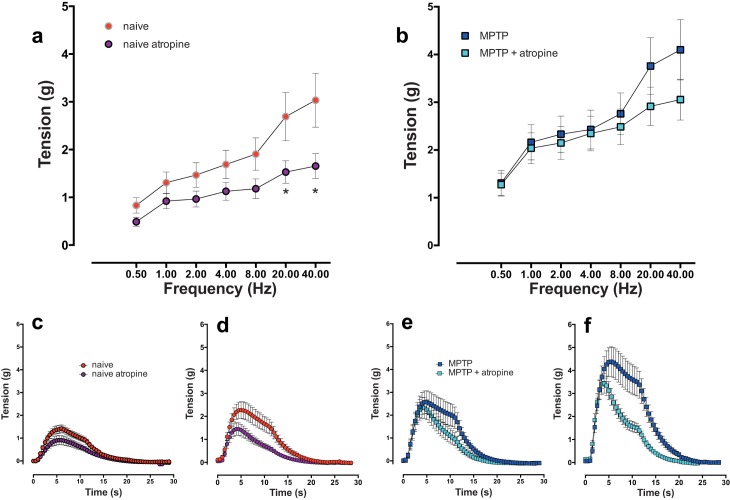
Frequency dependent increase in contractile response of isolated detrusor strips in response to trains of 20 pulses at frequencies ranging from 0.25 to 40 Hz in the absence or in the presence of 1 μM atropine in normal and equivalent tissues from MPTP animals respectively.In detrusor strips from drug naïve animals, atropine significantly inhibited peak contractile responses at frequencies above 20 Hz (a). In strips from MPTP-treated animals (b), atropine did not significantly decrease peak contractions. Time course of EFS-evoked contractile responses of detrusor strips from normal detrusor strips at 4 Hz (c) and 40 Hz (d) shows a biphasic contractile profile. In this tissue both phases of contraction were reduced by atropine while in MPTP tissues, atropine inhibited the second phase to a greater extent at the 4 Hz (e) and 40 Hz (f). Each data point represents mean ± sem (n = 5) * P<0.05.